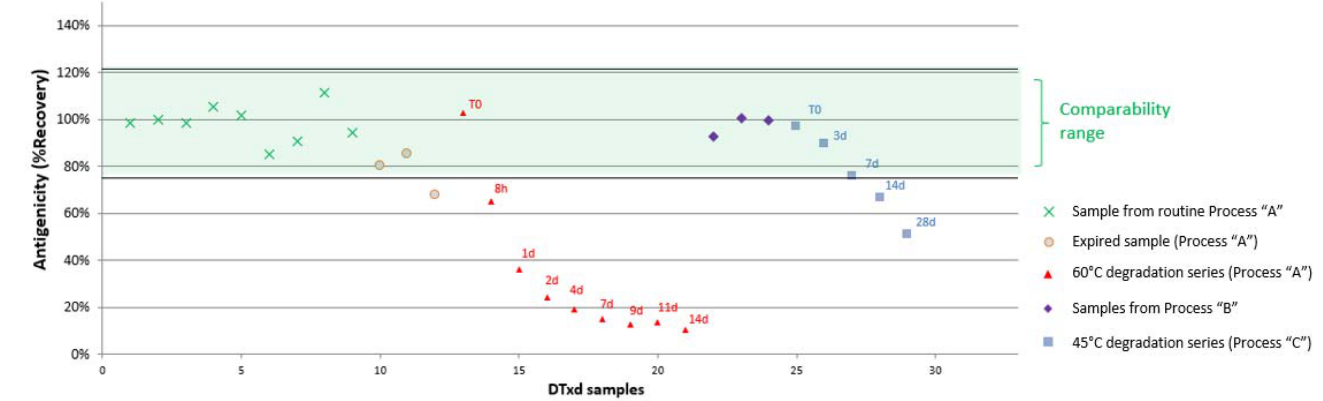
Figure 3. Antigenicity of intact, heat treated and expired DTxd samples in the SEAT using mAb 3-17. SEAT using mAb 3-17 was used to determine the antigenicity (%Recovery) of DTxd manufactured using the routine process (process A). Comparability range (green) is the average antigenicity (in %Recovery) ± 3 SD for nine lots of non-expired process A material (DTxd samples 1 to 9). Additional DTxd lots, including three expired process A lots (DTxd samples 10 to 12) and nine samples of a heat-treated process A lot (DTxd samples 13 to 21), as well as DTxd lots created using alternate